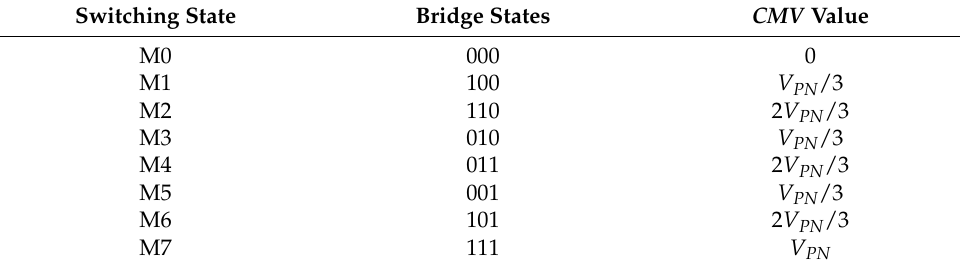
Figure 2. Traditional three-phase two-level voltage-source H6 inverter: ( a ) H6 inverter topology; ( b ) space vector modulation (SVM) diagram. Table 1. Common-mode voltage of traditional H6